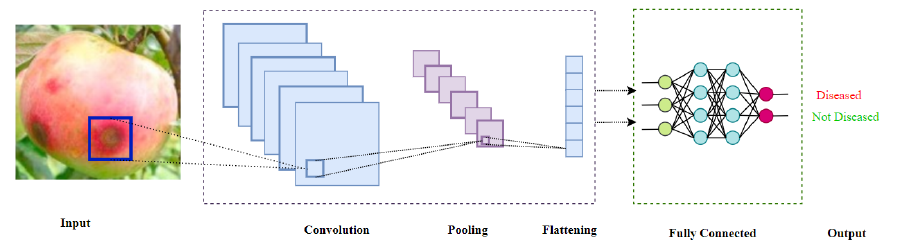
Figure 4. Disease identification through image